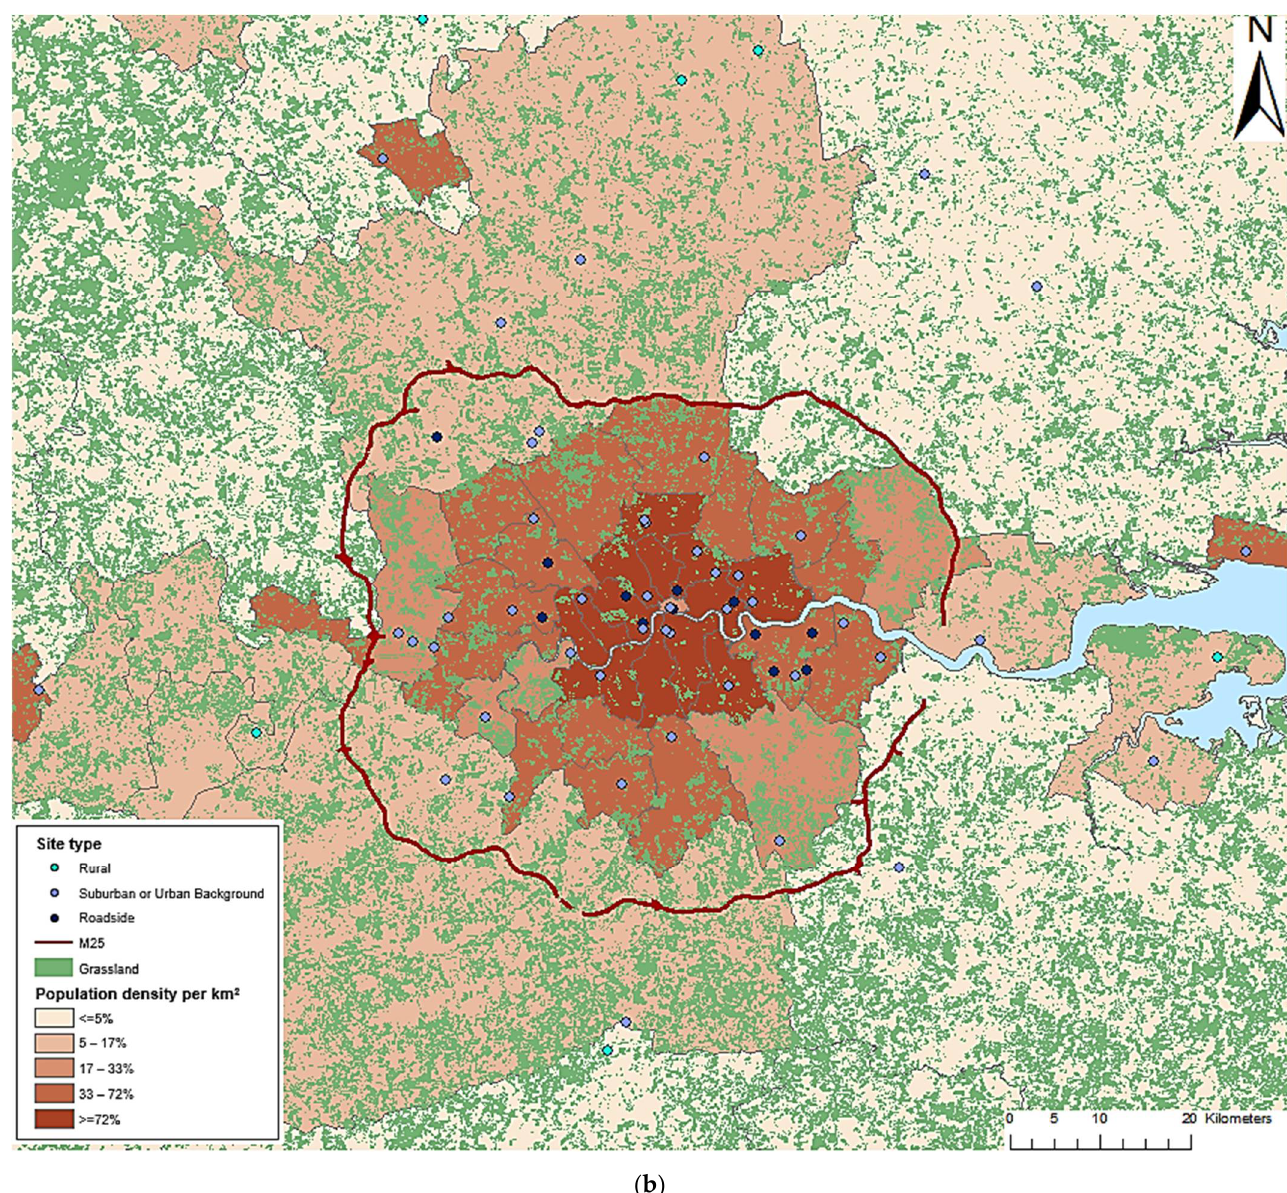
Figure 1. Map of the geographical location of the fixed monitoring network operated at the Greater London ( a ) study area for NO 2 , PM10 and PM2.5 and ( b ) extended study area for O 3 .